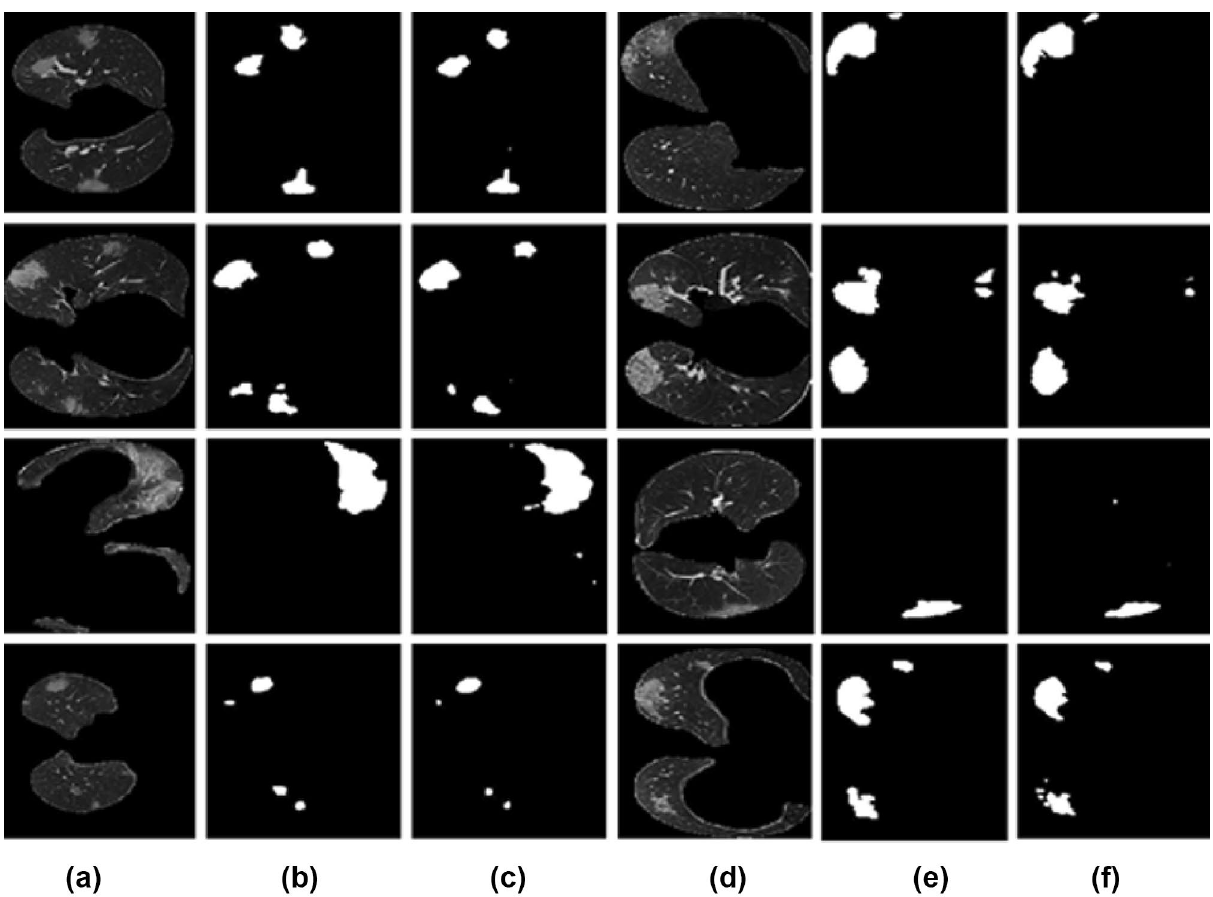
Figure 9. Visual comparison of COVID-19 infection segmentation results against GT. ( a , d ) The input image slices, ( b , e ) the ground truth, and ( c , f ) the output obtained from the proposed By examining each of the slices, it is evident that the proposed network captures most infections. Even though the arteries have the same intensity values, the proposed method is able to detect lung infections correctly. According to the results, the infection region network trained at the 20 th epoch with 128 × 128 × 32 patches and Adam optimizer with learning rate 0.0005 performed better. Here we got a validation accuracy of 96.83%. The colormap-based infection representation of the CT slices obtained from the second 3D UNet is shown in Fig. 10. The colormap ‘jet’ is used here. The range of pixel values of the detected infection region is represented by the scale bar on the right side. The radiologist or doctor will be able to determine the severity of the infected lung region using this method. The performance analysis of the proposed method for lung segmentation and lung infection segmentation is shown in Table 3. Table 4 shows the comparative analysis of the proposed method with the methods in current literature. Using UNet and the tversky loss function, Zhou et al. 10 detect the contaminated zone. The studies are con- ducted on two data sets: set 1 consists of 100 axial CT images from 60 patients with Covid-19. Set 2 consists of 9 volumes with 829 slices, of which 373 slices have been evaluated and segmented as COVID-19 instances by a radiologist. They achieved a Dice score of 83.1%, a Sensitivity of 86.7%, and a Specificity of 99.3%, respectively. Jin et al. 11 employed 1136 images, 723 of which were positives collected from five different hospitals, to develop their method. They used fully convolutional networks (FCN-8s), U-Net, V-Net, and 3D U-Net++ to analyse the results. The results show that the 3D UNet++ gives a dice coefficient of 0.754. Amyar et al. 12 presented a three-arm architecture. Here the reconstruction and segmentation are done by an encoder and two decoders. A multi-layer perceptron network performs the classification, and they got a dice coefficient of 0.78. The images are given to the classification system one by one in the method proposed by Wu et al. 13 . The patient is diagnosed with COVID-19 if the number of infected CT images exceeds a certain threshold. An activation map is also included in the classification model. An encoder-decoder method with enhanced feature modules is used for segmentation. On the segmentation test set, the segmentation method received a dice score of 78.3 %. The method by Fan et al. 14 , a parallel partial decoder is used to aggregate the high-level features and generate a global map. After that, implicit reverse attention and explicit edge attention are used to model the boundaries and enhance the representation. The Inf-Net with Res2Net gets a dice score, sensitivity, and specificity 68.2%, 69.2%, 94.3%, respectively. The Semi-Inf-Net got a dice, sensitivity, and specificity of 73.9%, 72.5%, 96.0%, respectively. The method proposed by Yan et al. 15 uses extensive data set consist of 21,658 CT images annotated